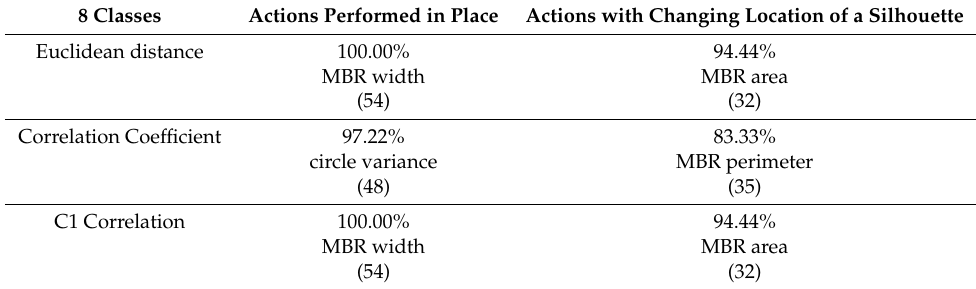
Table 1. Experimental results for the recognition of exercise types using 8 classes of the Weizmann dataset. The results are presented separately for actions performed in place and actions with changing location of a silhouette. The highest accuracy values are listed with the indication of the applied simple shape descriptor and the size of an action representation (given in brackets).